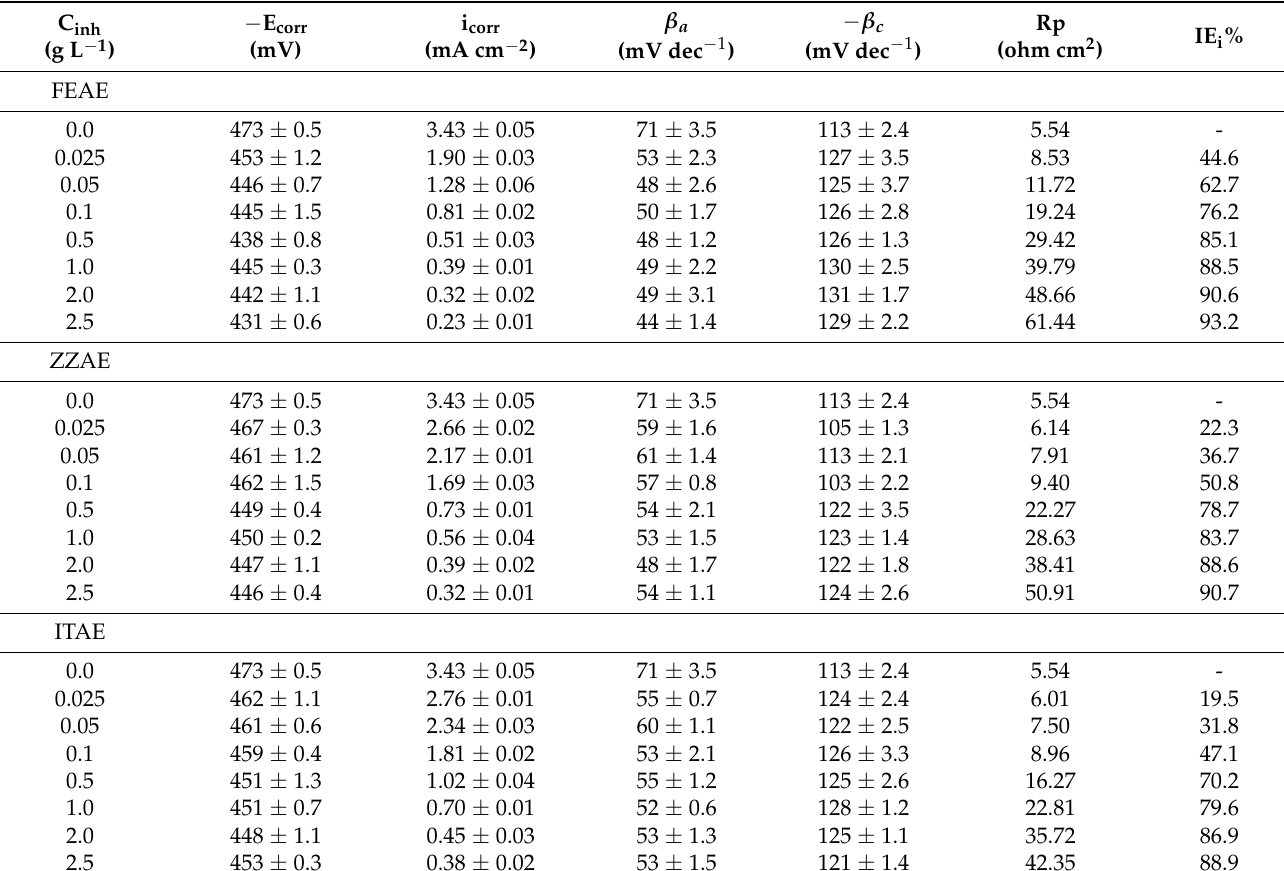
Table 4. Potentiodynamic polarization parameters for mild steel corrosion in 2 M H 3 PO 4 solutions with and without different concentrations of the studied plant extracts at 30 ◦